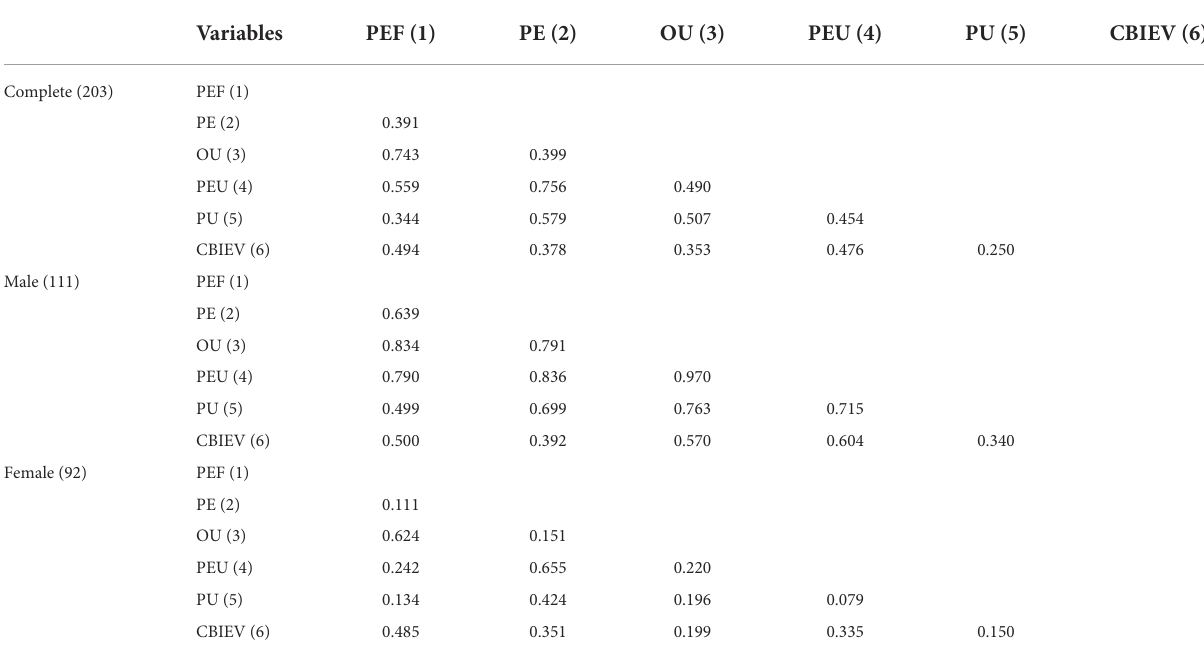
TABLE 5 Discriminant validity